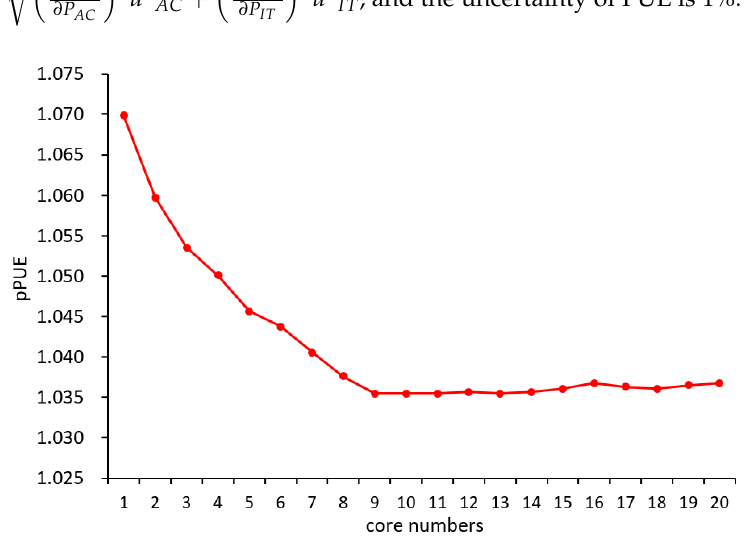
Figure 12. Partial power usage effectiveness (pPUE) of the CPU two-phase cooling system. The pPUE ranged from 1.038 to 1.07, indicating a decreasing trend when the number of cores was less than 9, with an average value of 1.05 (the highest value was obtained with one CPU core). The reason for the observed monotonous relationship is that the server power used in this study did not exceed the upper limit of the system’s cooling